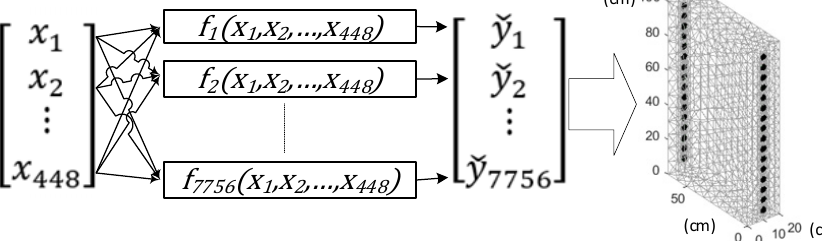
( b ) Figure 6. Thermal images of internal pillars: ( a )—several pillars, ( b )—single pillar.